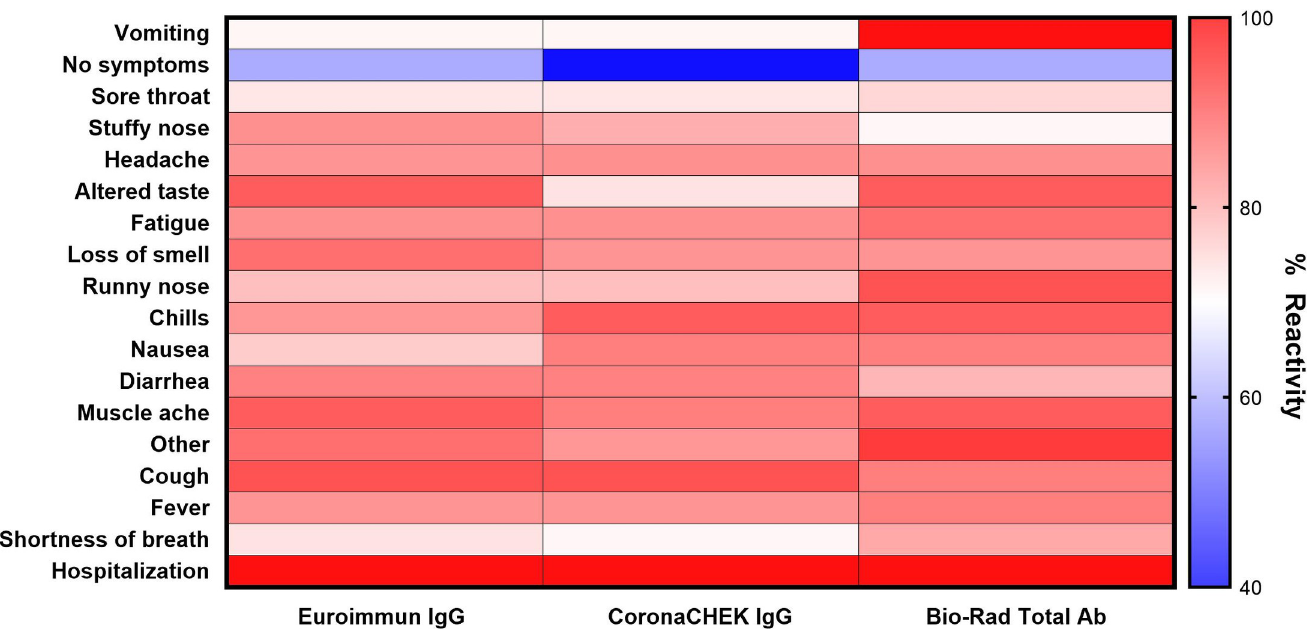
PLOS ONE | https://doi.org/10.1371/journal.pone.0264298 June 9,